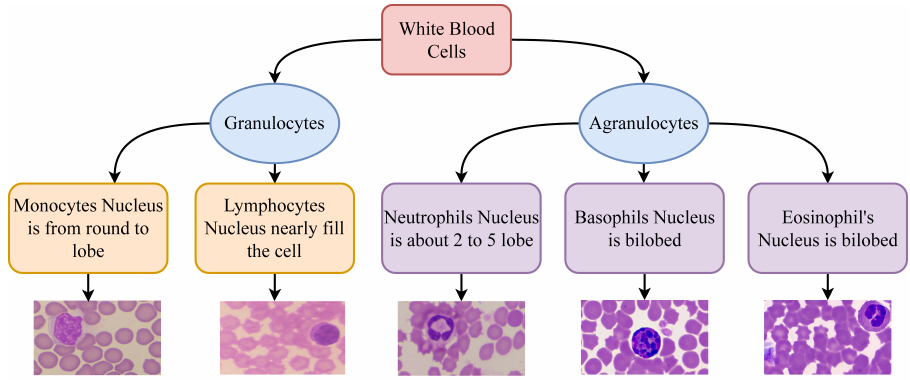
Figure 2. Hierarchy and classification of WBCs.